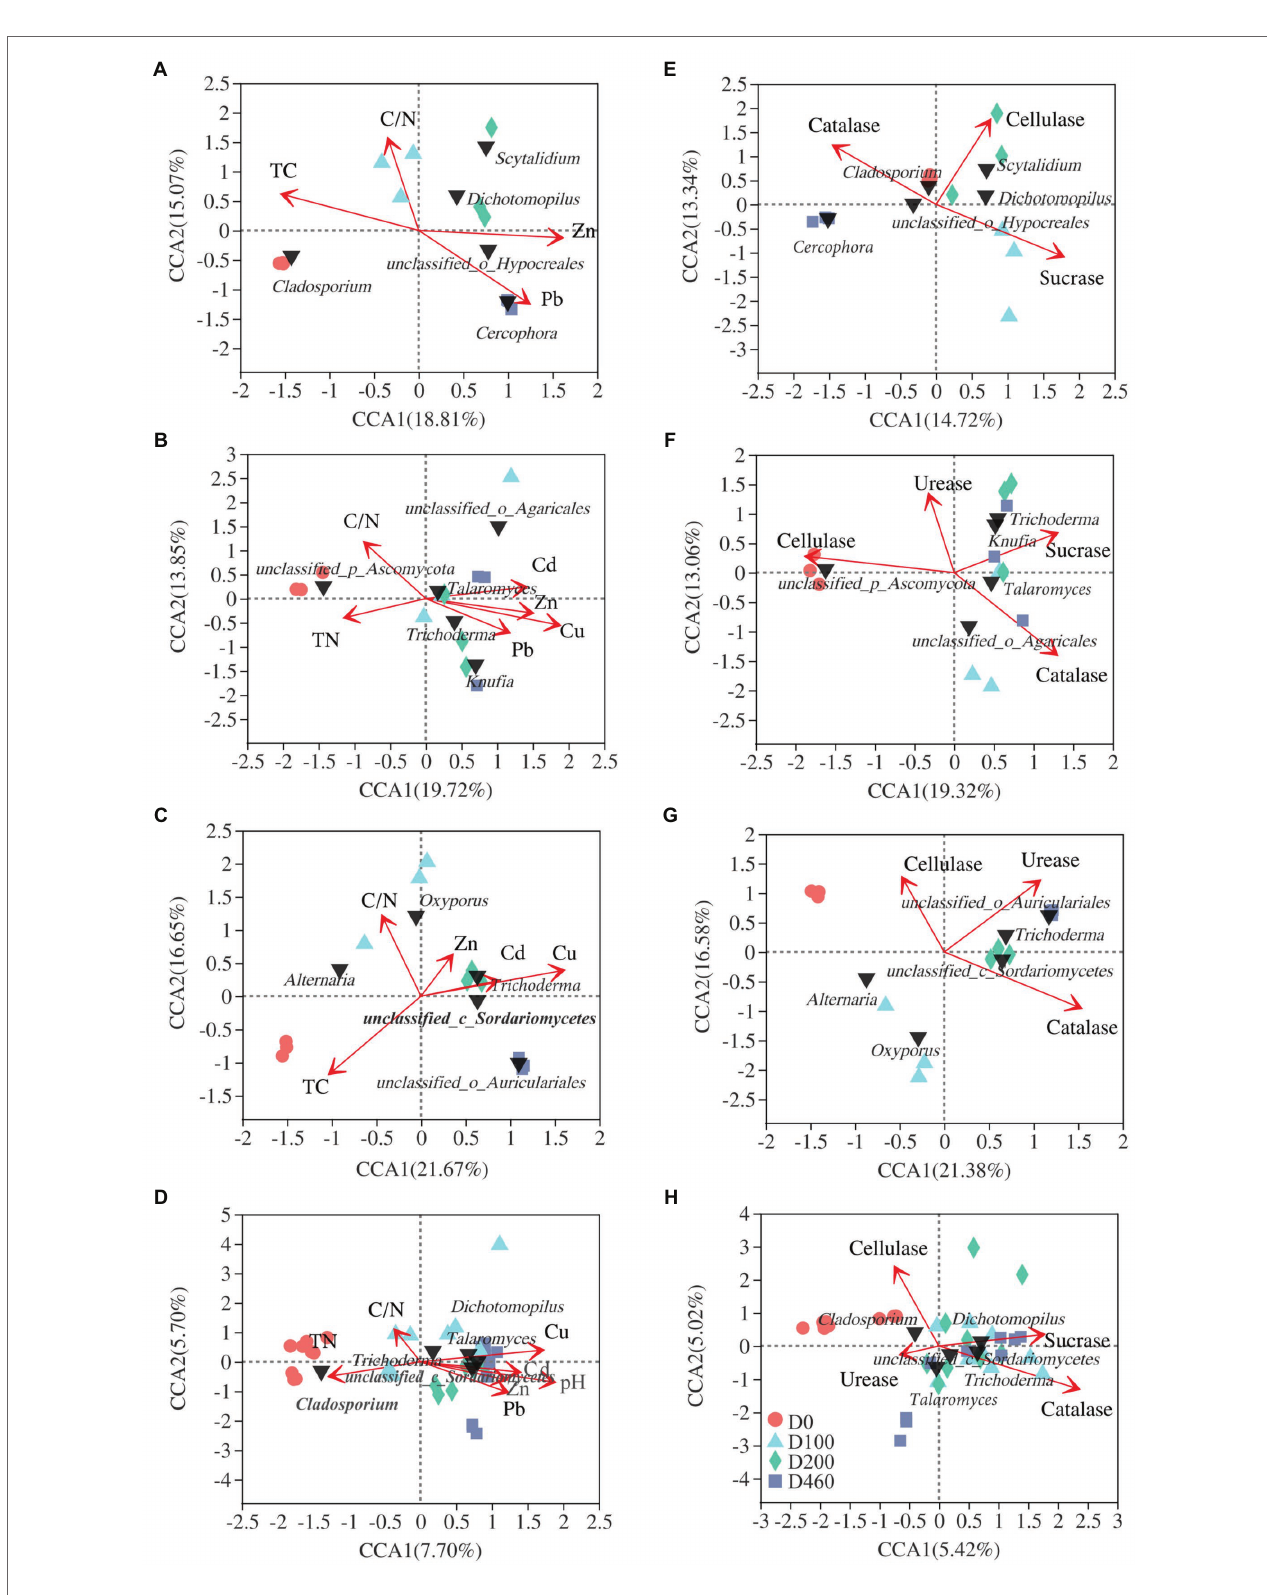
FIGURE 7 | CCA analysis of the top 5 fungal genera (black triangle) and litter properties (A-D) and enzyme activities (E-H) and fungal community structure in S516 (A , E) ; S536 (B , F) ; S560 (C , G) ; and the whole copper mining area (D , H)